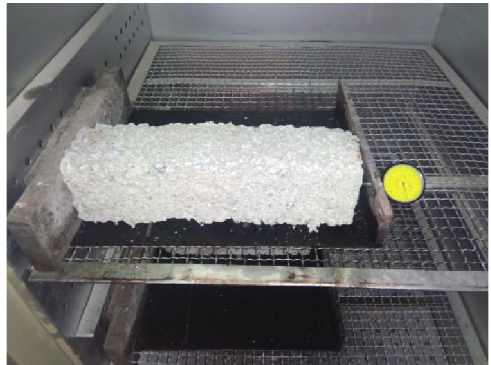
Figure 9: Sketch map of TST and test